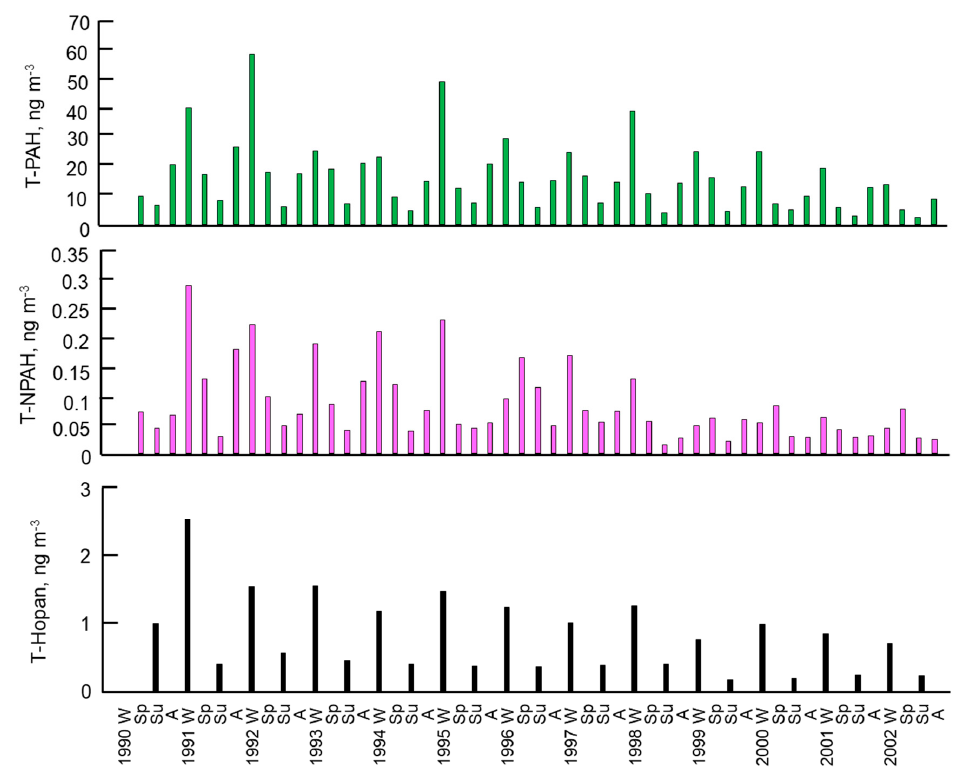
Figure 4. Atmospheric T-PAH, T-NPAH, and T-Hopane concentrations in Sapporo from 1990 to 2002 by season. Abbreviation: T-PAH = fluoranthene + Pyr + benz[ a ]anthracene + chrysene + benzo[ b ]fluoranthene + benzo[ k ]fluoranthene + benzo[ a ]pyrene + benzo[ ghi ]perylene + coronene, T-NPAH = 1-NP + 1,3-dinitropyre + 1,6-dinitropyre + 1,8-dinitropyre, T-hopane = 17 α (H)21 β (H)-30- norhopane + 17 α (H)21 β (H)hopane + 17 α (H)-22,29,30-trisnorhopane.